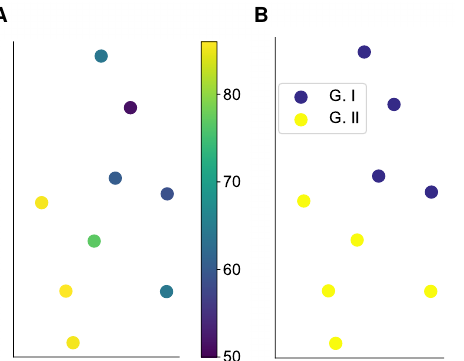
Figure 8. ( A ) Two-dimensional representation of the relevance vectors for each subject in the MI database obtained after applying t-SNE on (cid:36) n . ( B ) Groups identified by k-means. For the TE θ κα -based classifier the subjects grouped in G. I have an average accuracy of 0.59 ± 0.05, while those in G. II have an average accuracy of 0.80 ±